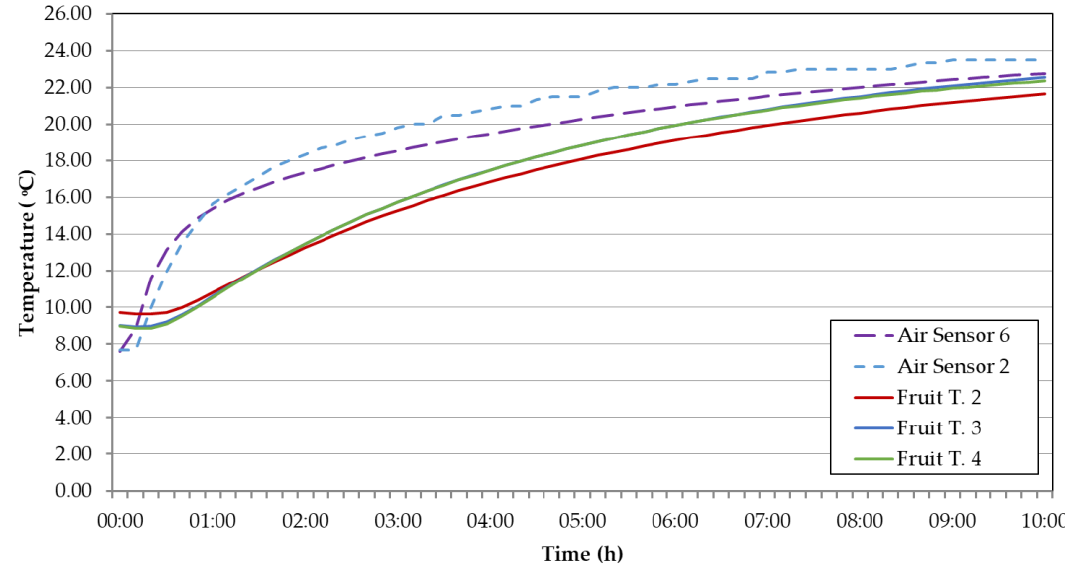
Figure 11. Variation in the temperature inside package 2, configuration B, during the heating pro- cess.